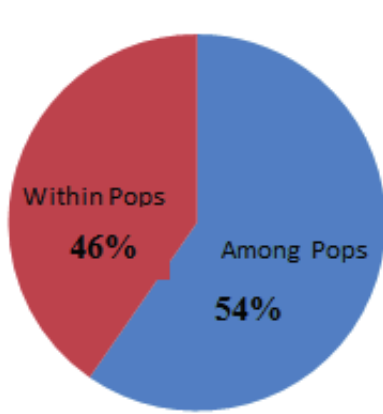
Figure 3. AMOVA test of the studied populations.